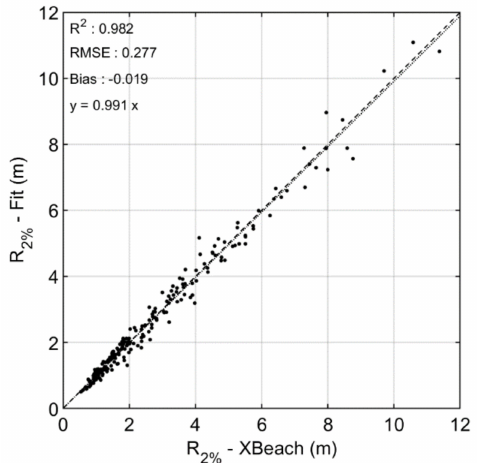
Figure 11. Comparison of XBeach-NH+ and the empirical relation (Equation (25)) for run-up R 2% . Dashed line indicates unity (y =